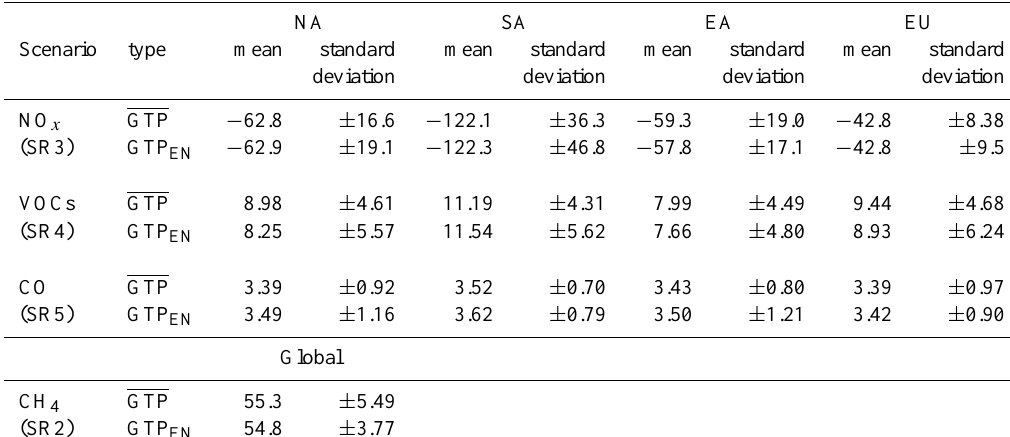
Table 6. As Table 4 for the 20 year GTP.